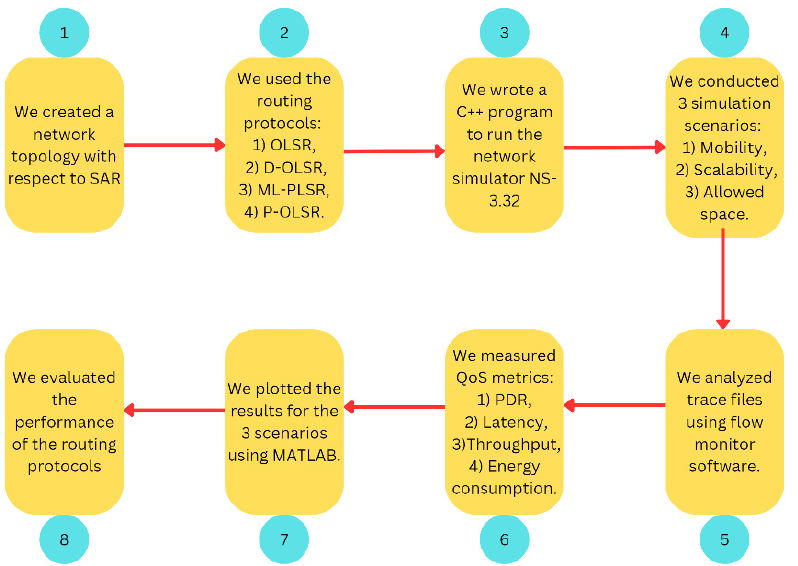
Figure 1. Workflow of the proposed approach.